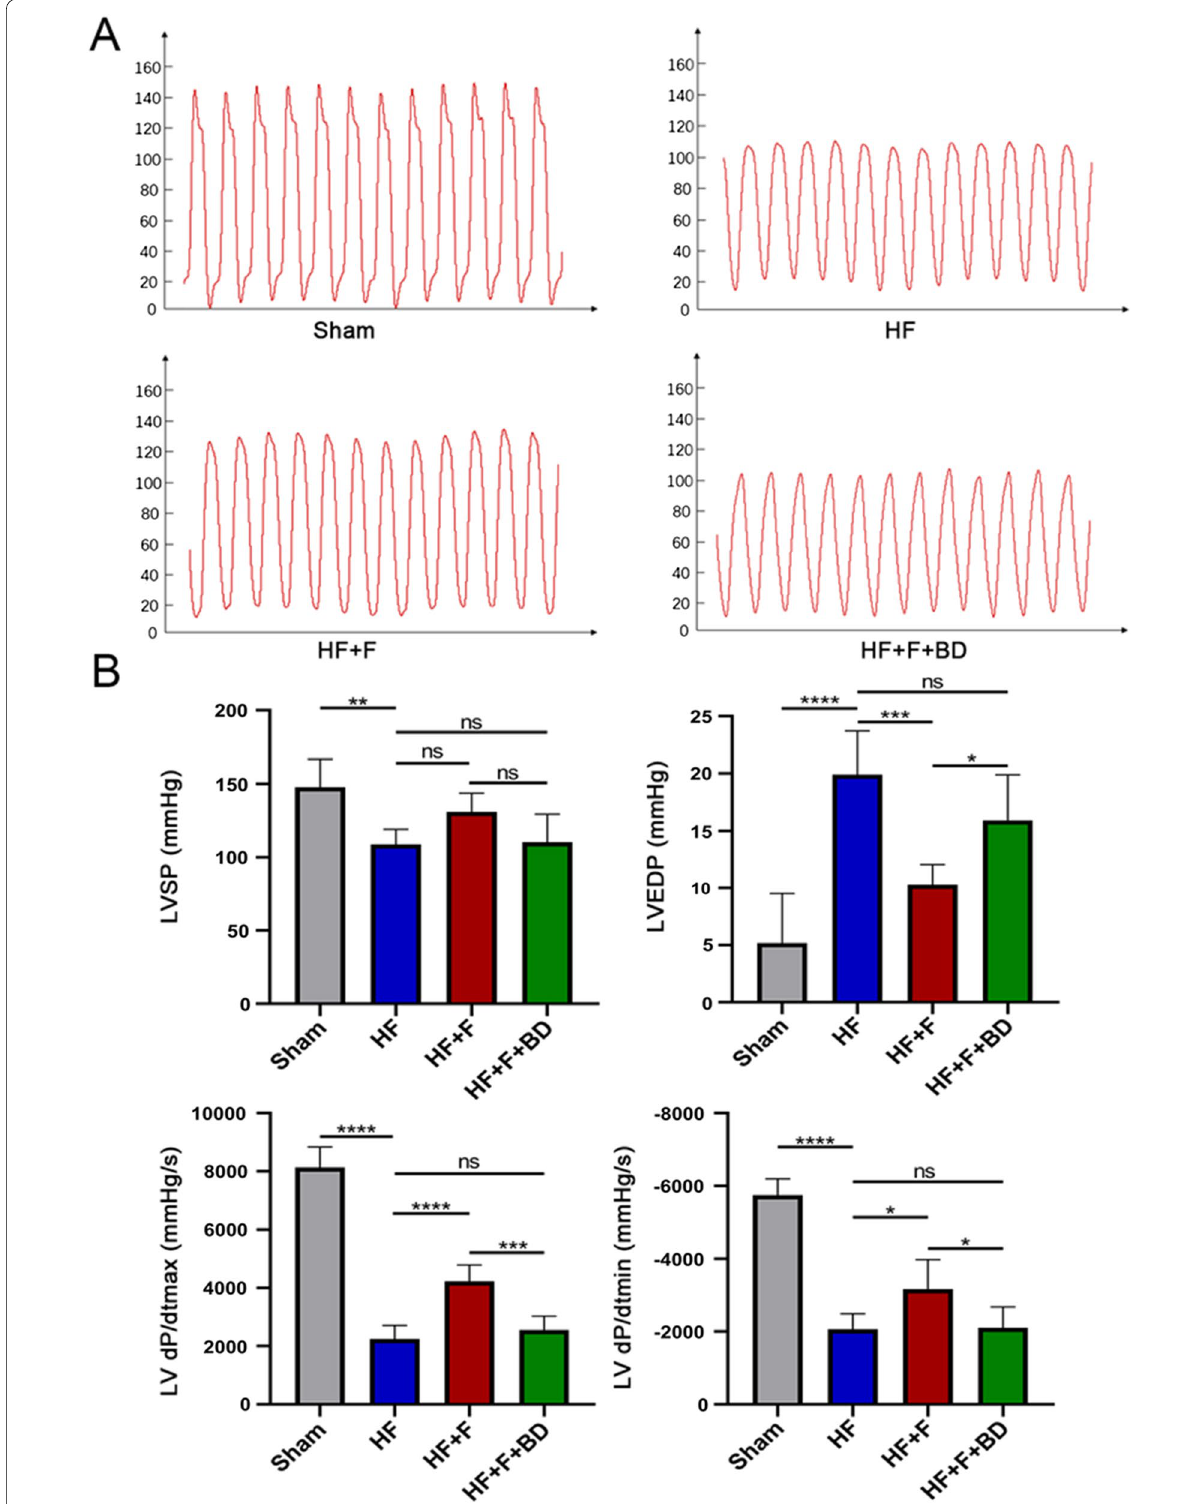
Fig. 2 Stimulation of sigma-1 receptor enhanced hemodynamics in PIHF rats. A Representative left ventricular pressures images in all groups; B LVSP, LVEDP, LV dP/dt max , and LV dP/dt min in rats 6 weeks after MI or sham operation. *P < 0.05; **P < 0.01; ***P < 0.005; ****P <